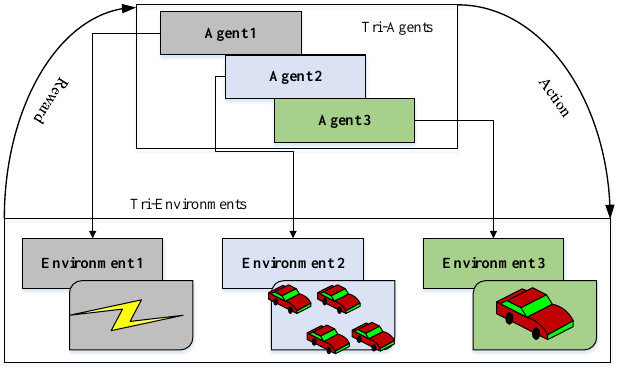
Figure 4. Tri-agent reinforcement learning (TA-RL)-based sensing decision-making. Table 1. Tri-agents and responsibilities.